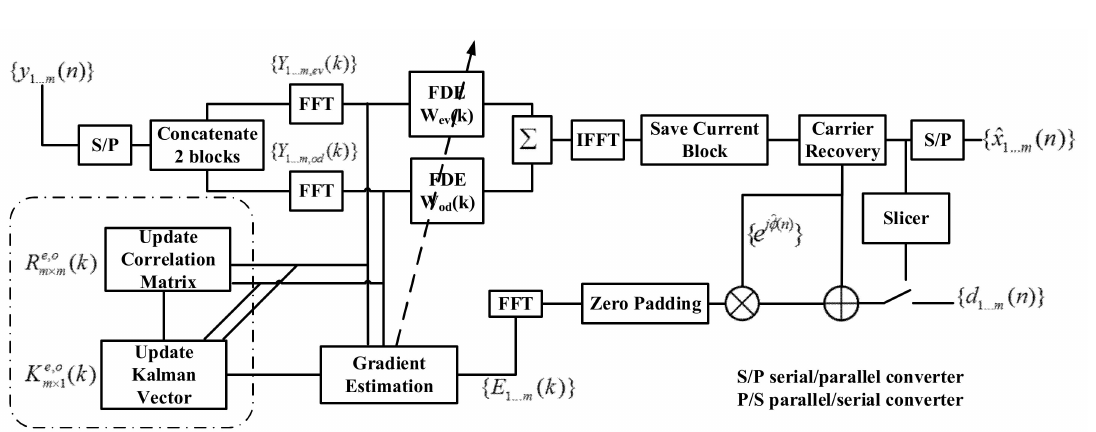
Figure 4. Block diagram of the RLS